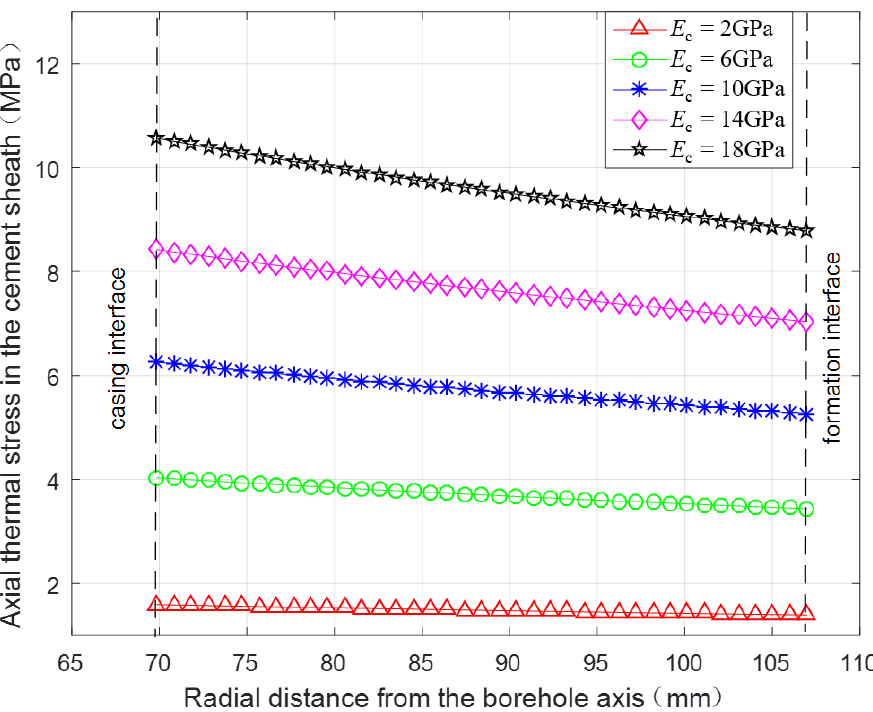
Figure 15. Radial distribution of the axial thermal stress in the cement sheath under different elasticity moduli of the cement sheath.